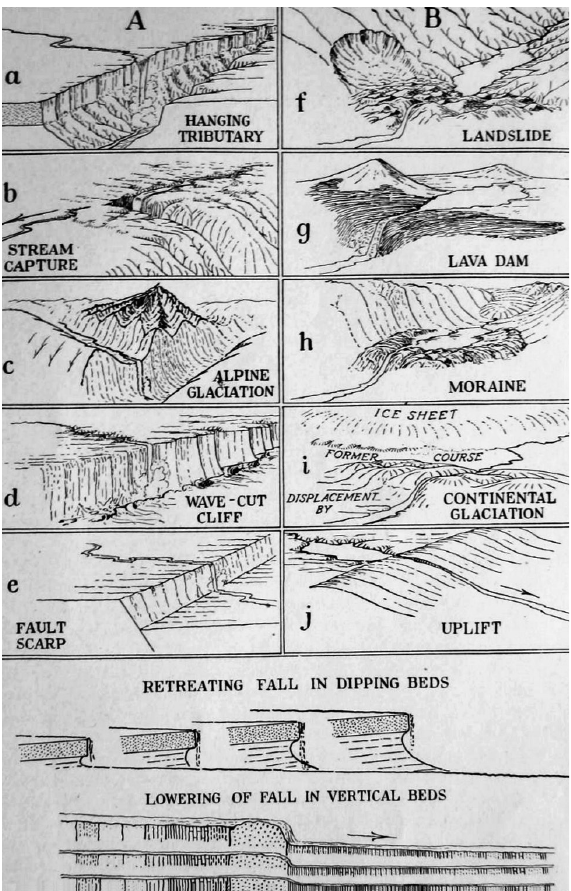
Fig. 1. Lobeck’s classification of types of